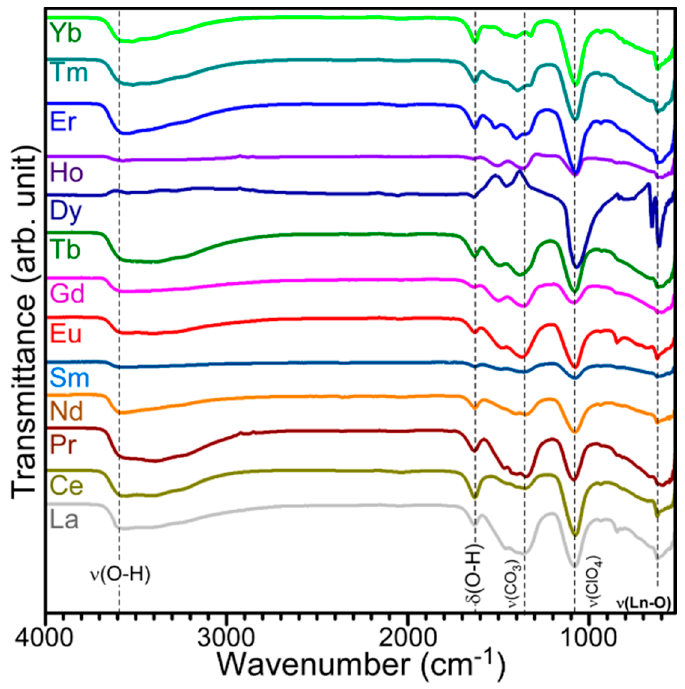
Figure 4. Transmittance FT-IR profiles for electrodeposited Ln elements on carbon sheets.